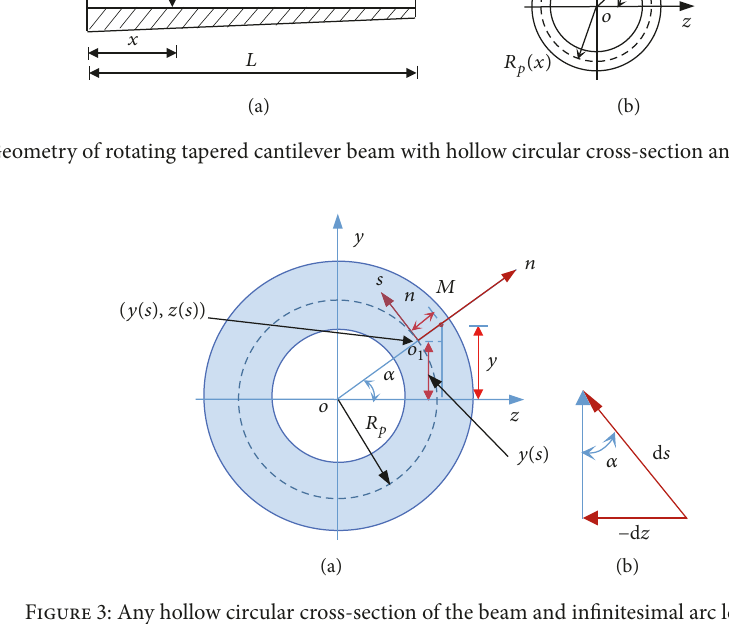
Figure 3: Any hollow circular cross-section of the beam and infinitesimal arc